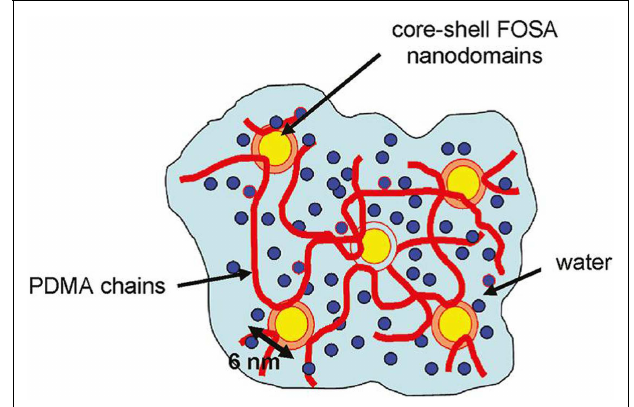
FIGURE 2 | Hydrogel made from a copolymer of dimethyl acrylamide (PDMA) and fluorinated acrylate (FOSA), which forms micelles by strong hydrophobic associations .The micelles also serve as physical crosslinks of the hydrogel. Reprinted from Hao andWeiss (2011) with